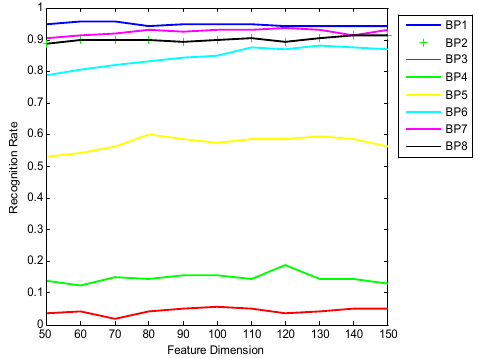
Fig.3 Variation in recognition rate of each bit-plane with the